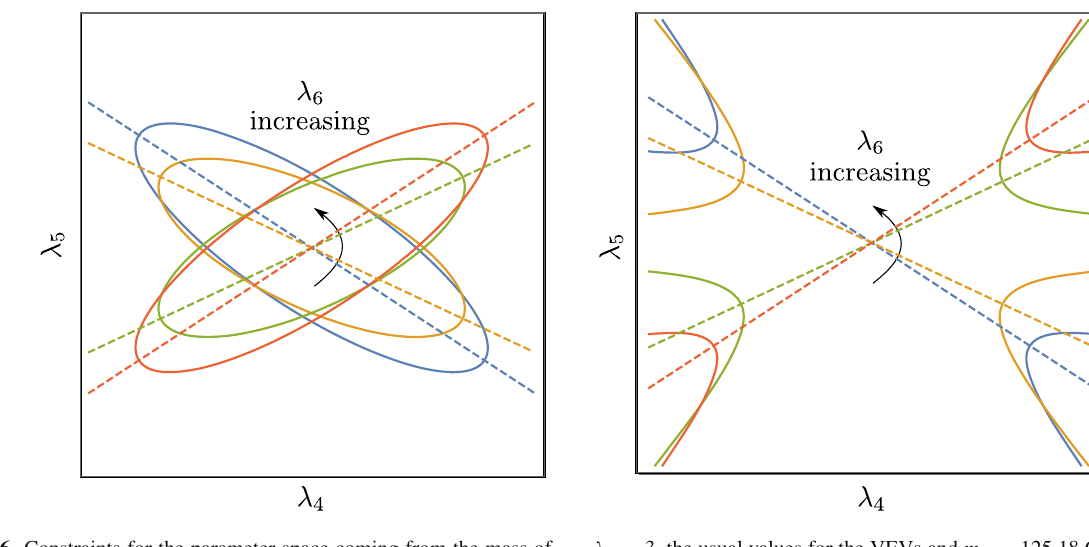
Fig. 6 Constraints for the parameter space coming from the mass of the Higgs boson produces ellipses and hyperbolas in the λ 5 − λ 4 plane according to Eq. (42). In this particular example, we took λ 1 = 4 + λ 2 ,